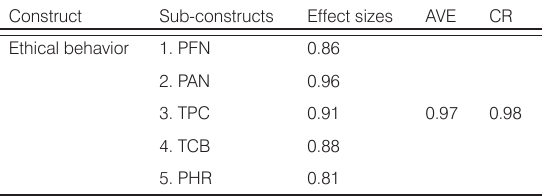
Table 3. Effect sizes of 5 sub-constructs, AVE, and the CR of